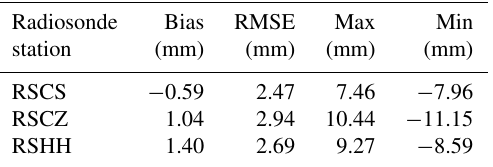
Table 3. Comparison between radiosonde-observed and GNSS- interpolated PWV at the three radiosonde stations.